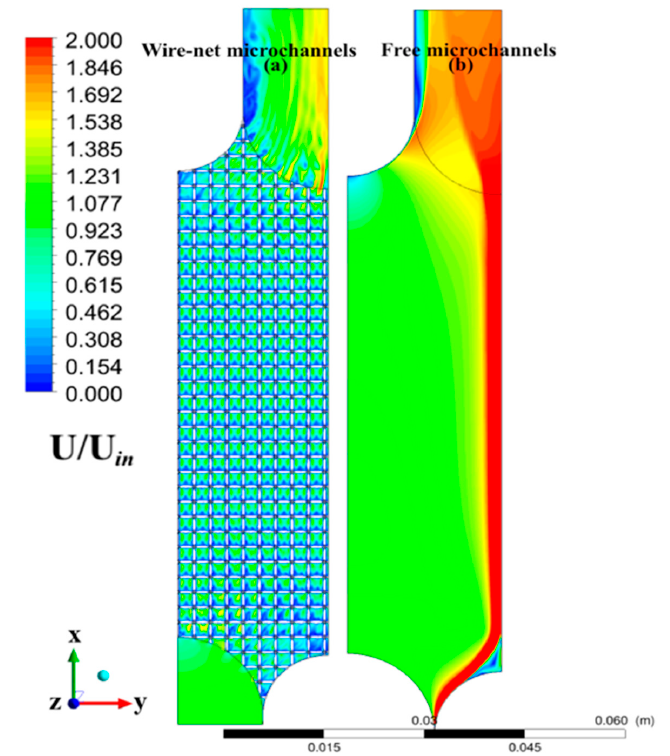
Figure 3. Non-dimensional velocity contours of microchannels with and without the wire-net.